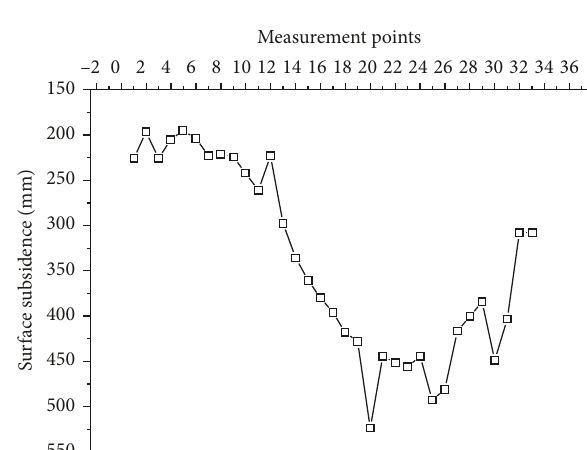
Figure 17: The subsidence curve of the strike of Haizi II 1024 face after mining II 1022